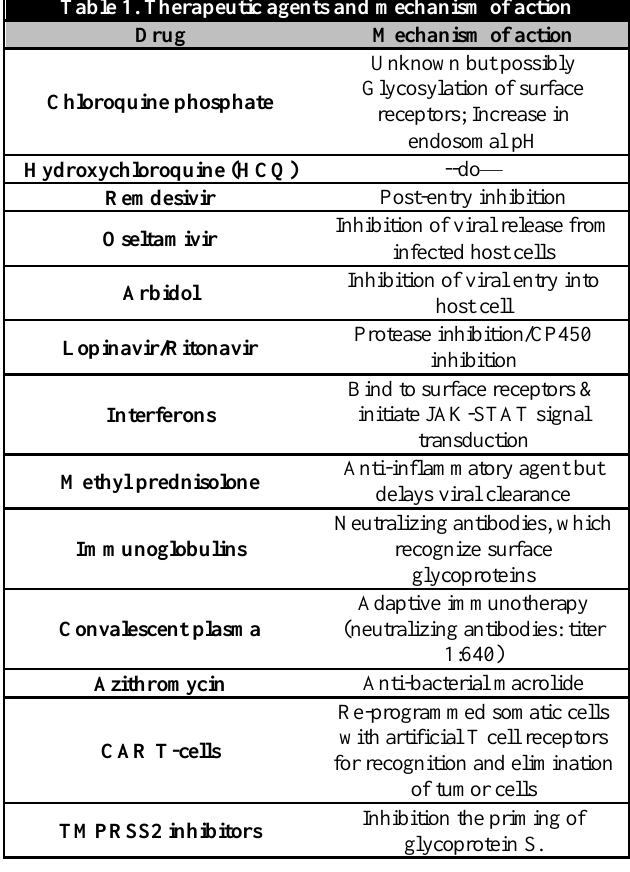
Table 1. Therapeutic agents and mechanism of action